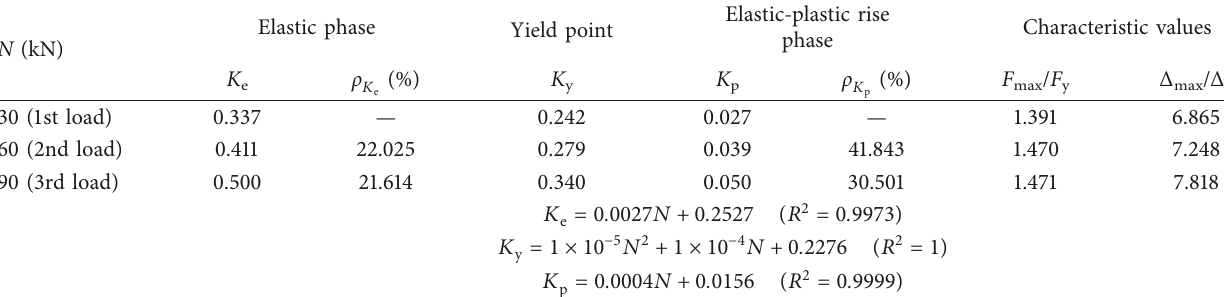
Table 4: The characteristic parameters of the three-phase linear